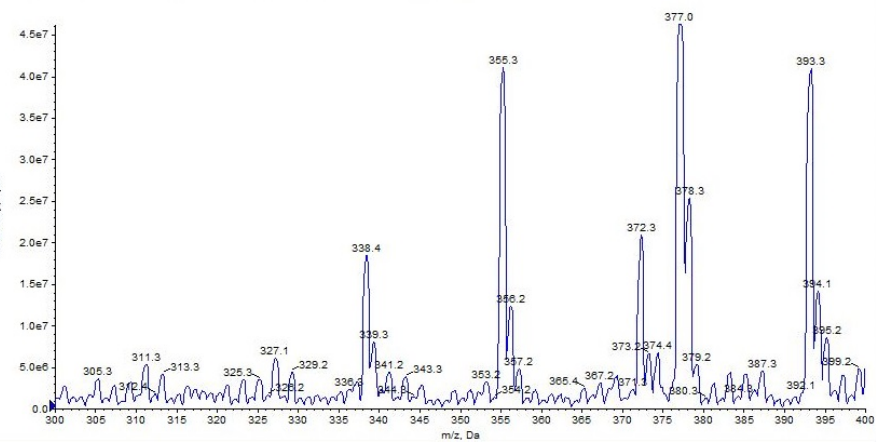
Figure 6. Product ion scan of URB597 compound obtained by HRMS.